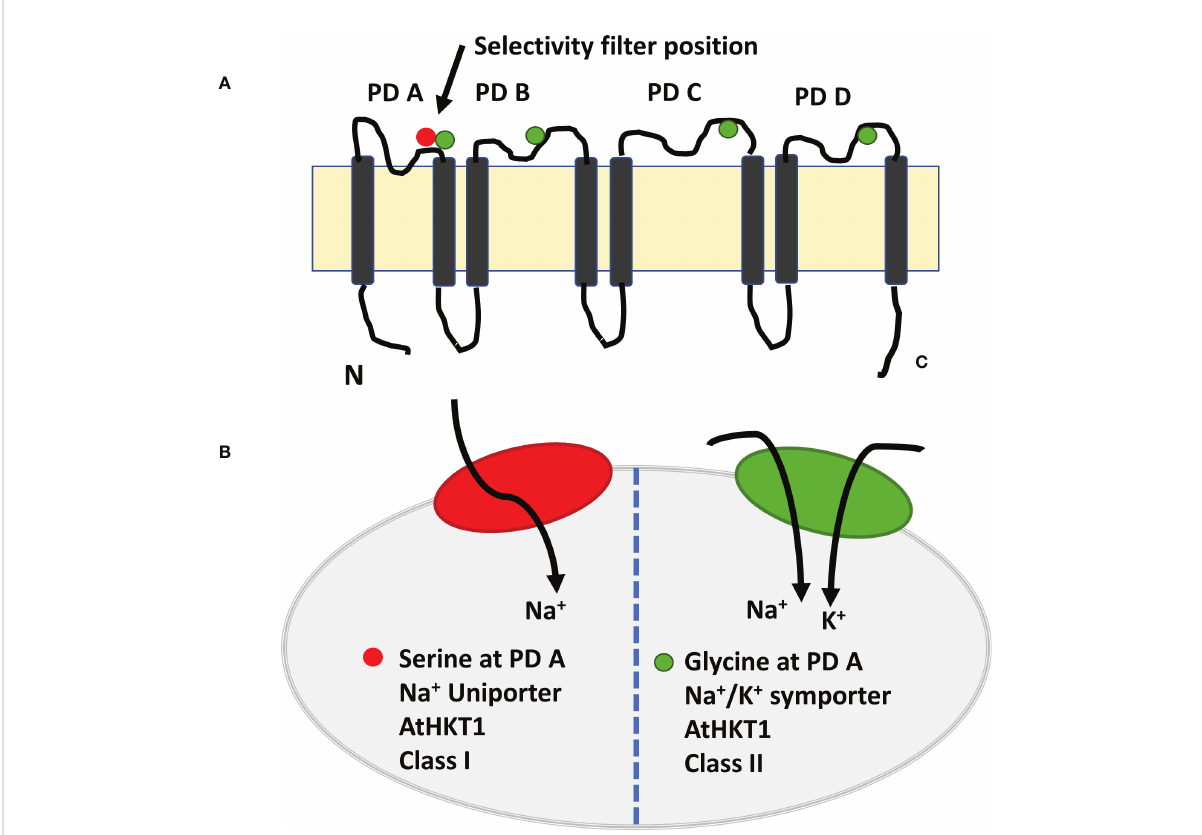
FIGURE 3 Model of high af fi nity potassium channel HKT1 with eight transmembrane domain and four pore domains. (A) The selective pore or selectivity fi lter in class 1 has Ser-Gly-Gly-Gly, whereas members of class 2 have selective pore with Gly-Gly-Gly-Gly. Four amino acids are placed on top of the four short loops or PD loop and make it as selectivity fi lter. The selective fi lters transport the Na + ion selectively from xylem vessel to xylem parenchyma cells as xylem-Na-unloading process. (B) . Class 1 HKT channel act as Na + uniporter only, whereas Class 2 HKT channel as Na + and K + channel (Adapted from Ismail and Horie, 2017; Naeem et al., 2020; Mansour and Hassan,